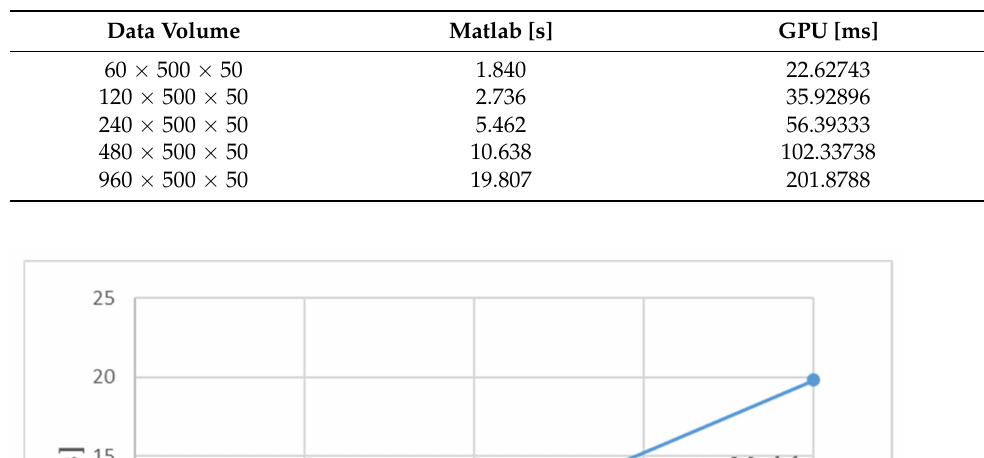
Table 4. Simulation time comparison.